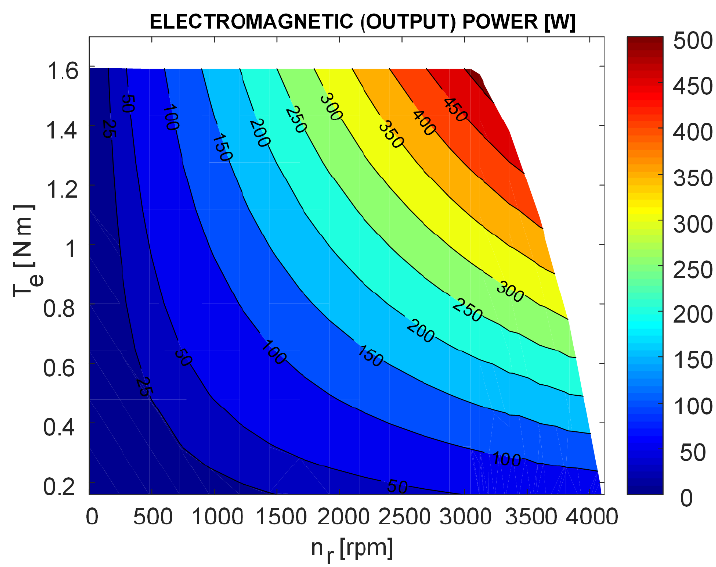
Figure 7. Shimano Steps IPM output power.